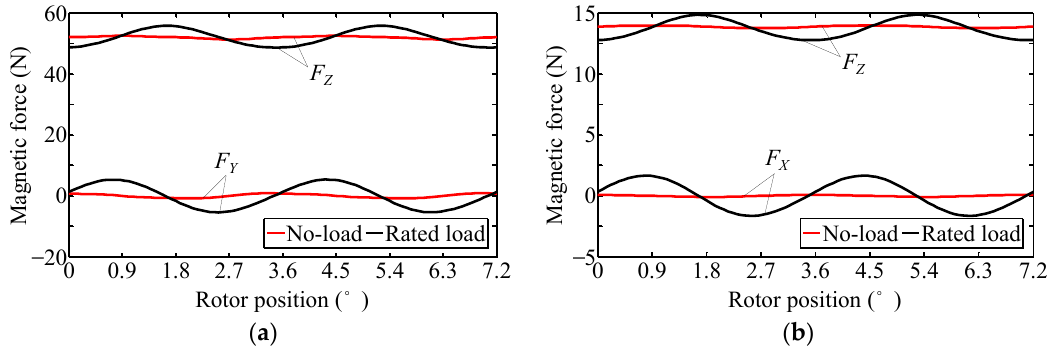
Figure 25. Calculated magnetic stress by2-D FEA. ( a ) Sub-motor1; ( b ) Sub-motor2.